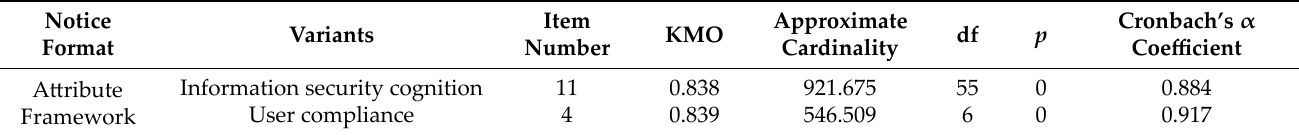
Table 2. Reliability and Validity Analysis